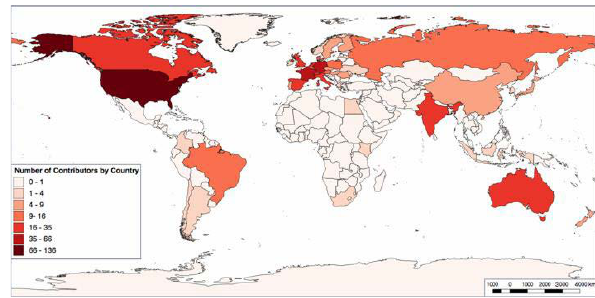
Figure 2. Map of geocoded unique contributors by country (world country map by GADM: http://gadm.org)